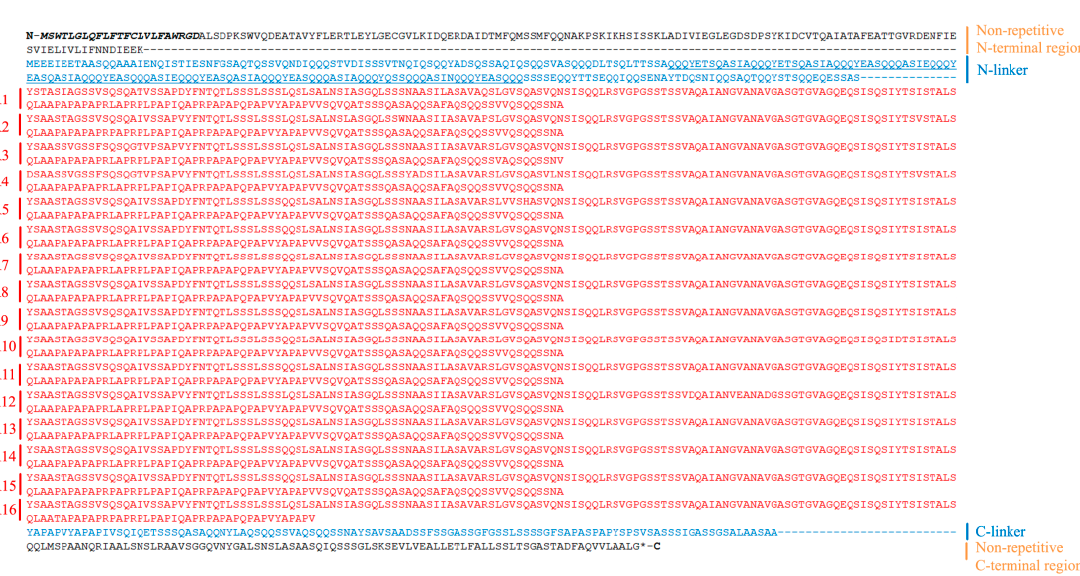
Figure 1. Complete A. ventricosus pyriform spidroin 1 (PySp1) sequence. The starting position is marked by amethioine (M), with an asterisk in the stop position. The sequence contains the non-repetitive N- and C-terminal regions, as well as two linker regions and the highly repetitive central region. Bold italics mark the signal peptide region. The underlined region is the N-linker. Gaps (-) are used for repeat unit alignment. Black is used to denote the non-repetitive N- and C-terminal, while linker regions are blue.